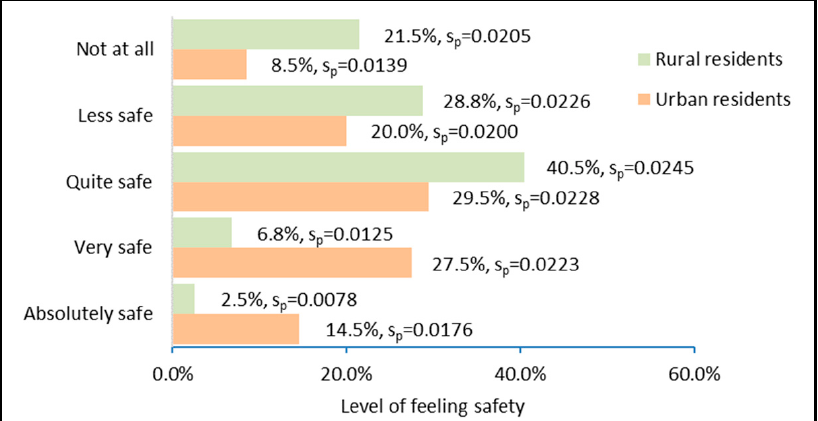
Figure 5. Residents’ feeling of safety about the wild boar invasion.